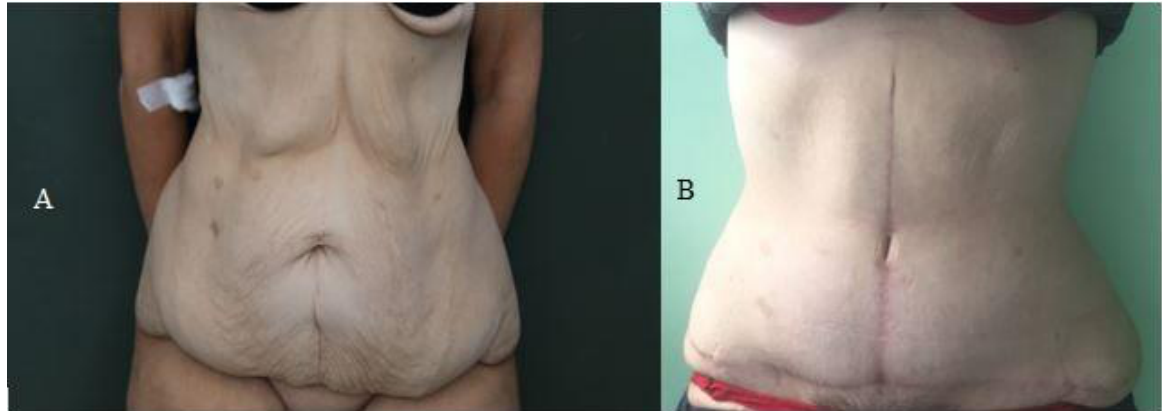
Figure 6. ( A ) A preoperative photo of a patient undergoing vertical abdominoplasty with recon- struction of a new umbilicus. ( B ) The same patient 12 months after surgery.